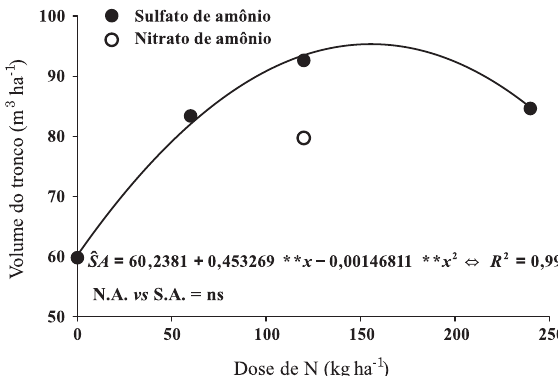
Figura 1. volume do tronco do clone aec1528 ® de eucalipto, aos 30 meses de idade, em doses de n aplicado como sulfato de amônio (s.a.) e por nitrato de amônio (n.a.) na dose de 120 kg ha -1 . **: significativo a 1 % e ns: não significativo até 10 %, respectivamente, pelo teste